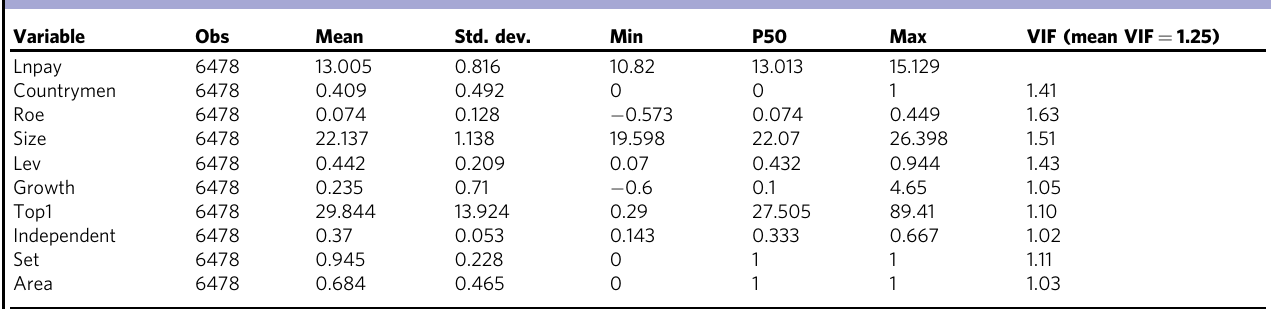
Table 3 Summary